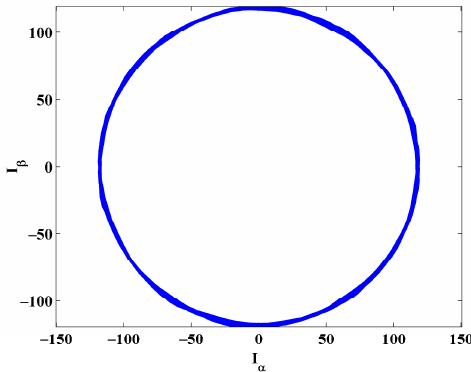
Figure 3. Trajectory of the current with no fault at 1000 rpm/100 Nm.